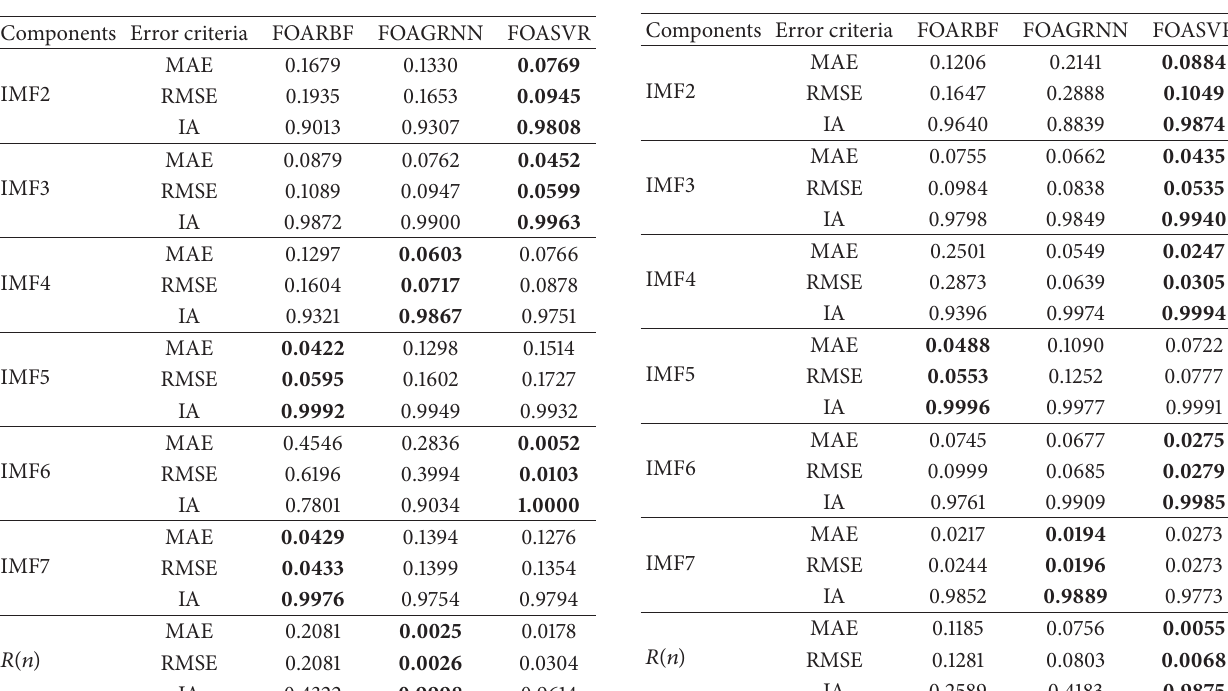
Table 4: The forecasting results of model selection among the FOARBF, FOAGRNN, and FOASVR in spring.